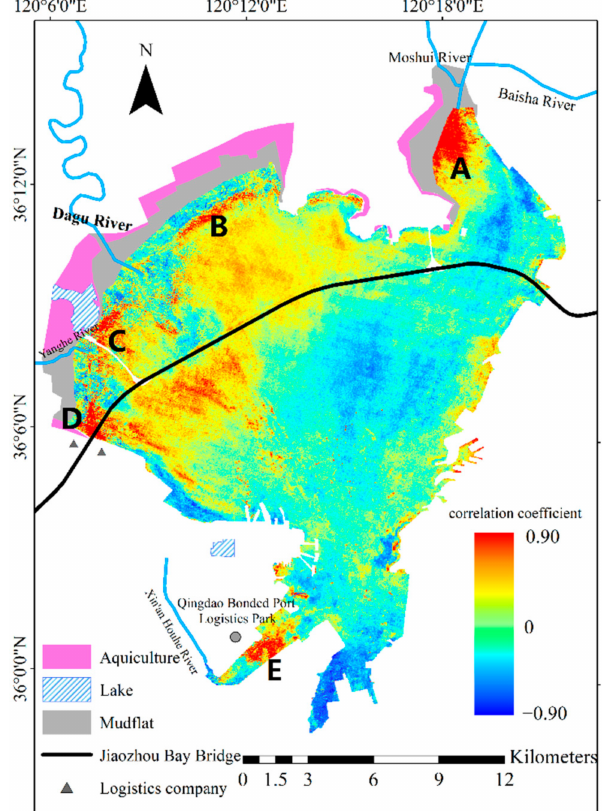
Figure 11. Pixel-by-pixel correlation analysis between the monthly average TSSs and Dagu River discharge. The color bar indicates the value of Pearson’s correlation coefficient (r). A, B, C, D, and E are five high-value